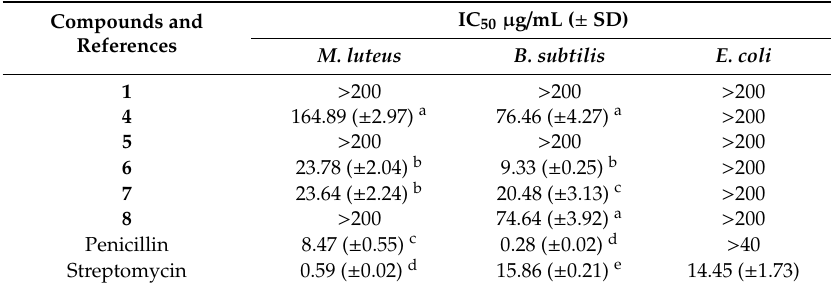
Table 2. Antimicrobial activity of synthesized compounds 1 , 4 – 8 .